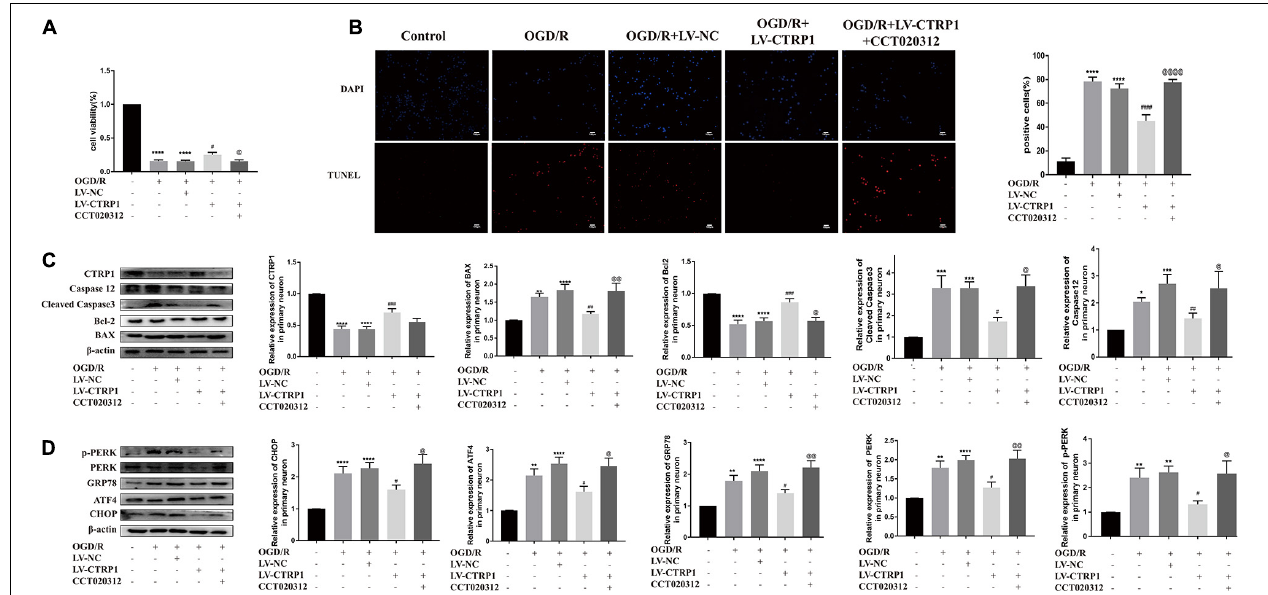
FIGURE 9 | CCT020312 reversed the effect of CTRP1 on apoptosis and the PERK signal pathway after OGD/R. (A) MTT analyzed the cell viability in neurons. n = 4 per group. (B) TUNEL analyzed apoptosis in neurons. n = 3 per group. The representative images were acquired under × 200 magnification, scale bars = 100 µ m. (C) The expression of CTRP1, BAX, Bcl-2, Cleaved caspase 3, Caspase 12 was analyzed by Western blot. n = 4 per group. (D) The relative expression of CHOP, GRP78, ATF4, PERK and p-PERK in neurons. n = 4 per group. **** p < 0.0001, *** p < 0.001, ** p < 0.01, * p < 0.05 vs. control group, #### p < 0.0001, ### p < 0.001, ## p < 0.01, # p < 0.05 vs. OGD/R + LV-NC group, @@@@ p < 0.0001, @@ p < 0.01, @ p < 0.05 vs. OGD/R + LV-CTRP1